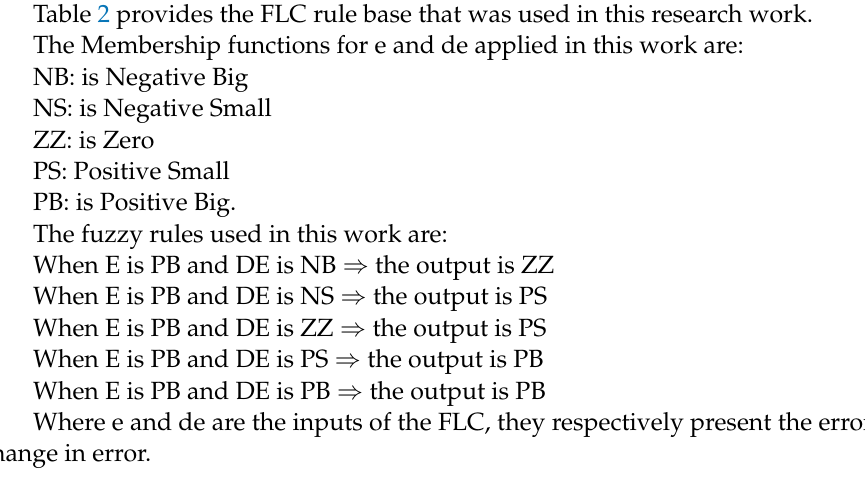
Table 2. Fuzzy rule table